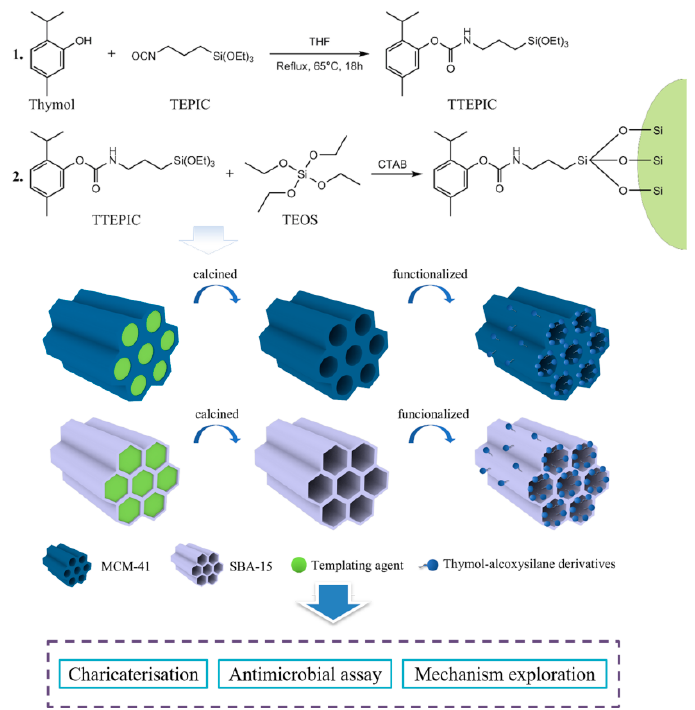
Figure 1. Preparation of functionalized mesoporous silica.